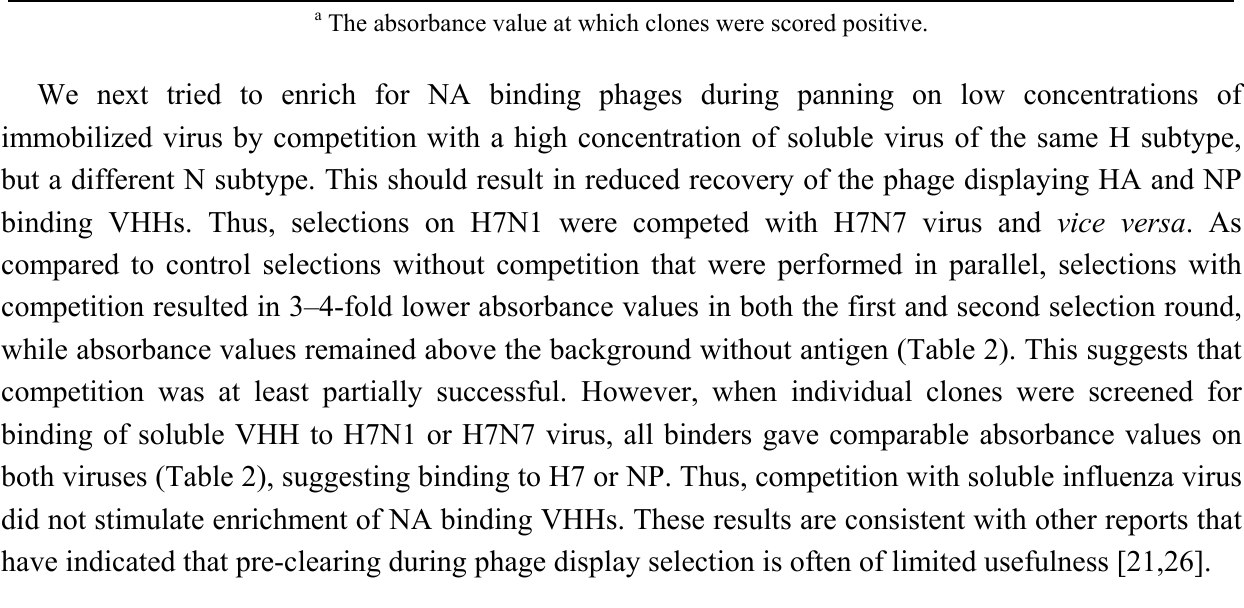
Table 2. Phage display selection of N1 or N7 binding VHHs by competition with other viruses. Phage libraries were first incubated with or without a high concentration of soluble H7N7 or H7N1 virus and, subsequently, selected using low concentrations of immobilized, H7N1 or H7N7 virus, respectively. Clones were screened for binding to immobilized H7N1 and H7N7 virus by incubation with E. coli -produced soluble